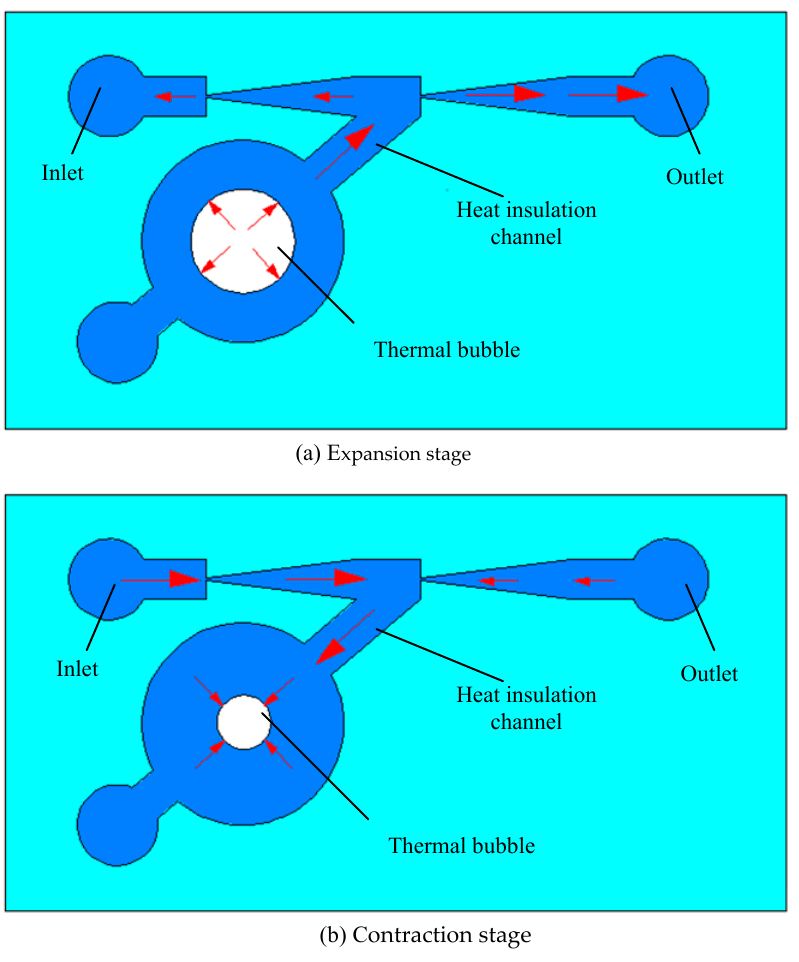
Figure 3. Working principle of the heat source insulation micropump. ( a ) Expansion stage; ( b ) Contraction stage.